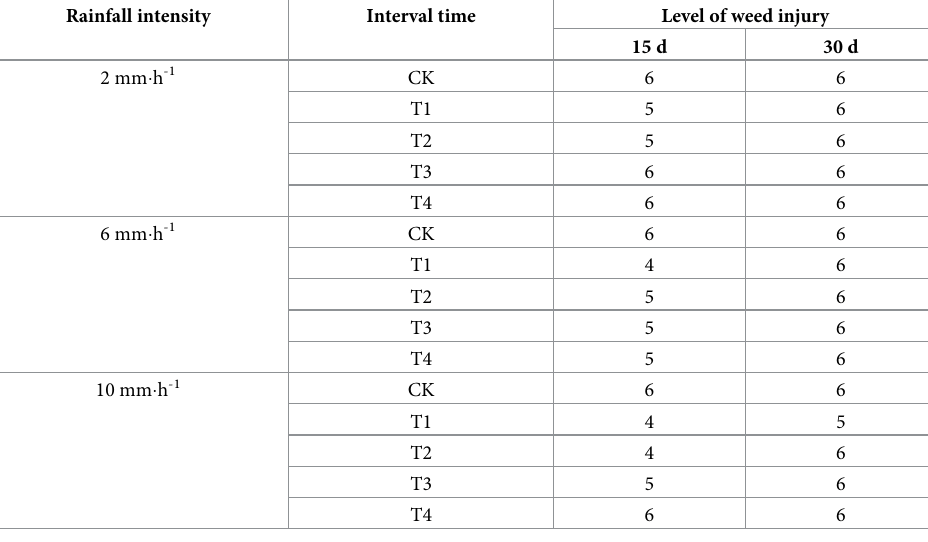
Table 3. Weed injury level at 15, 30 d after application of mesotrione and simulated rainfall. Rainfall